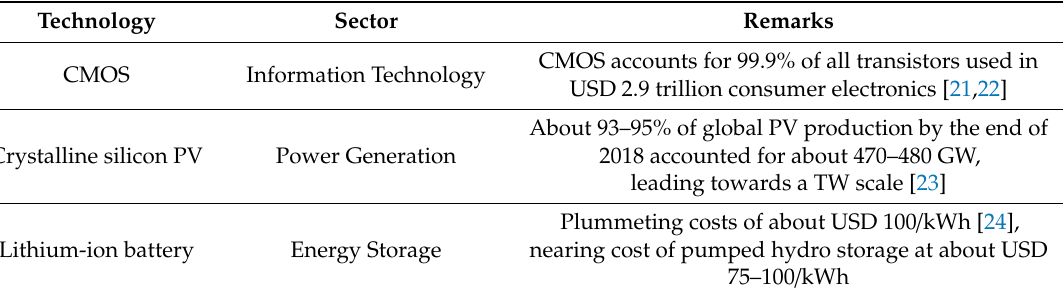
Table 1. Transformative role of technologies in the IT and power sectors.